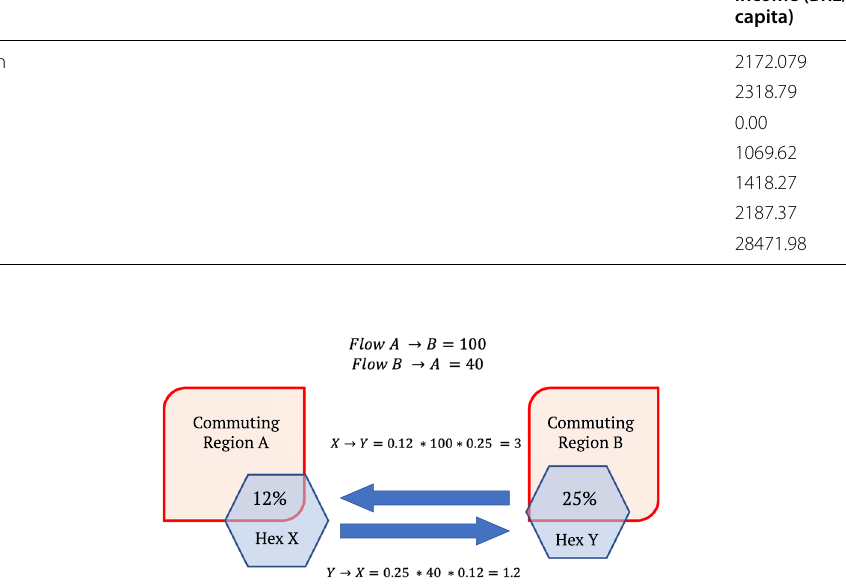
Fig. 3 Travel survey data interpolation strategy from travel zones to hexagon cells. Outflow and inflow are proportional to a hexagon cell’s overlap with a travel zone. To estimate travel patterns within a given hexagon, known inflow and outflow between travels zones A and B are proportionally allocated based on the overlap. For example, Hexagon X overlaps with 12% of Region A, and therefore 12% of Region A’s outflow is assigned to Hexagon X. Hexagon Y overlaps with 25% of Region B, and therefore 25% of the 12% outflow is assigned to Hexagon Y as